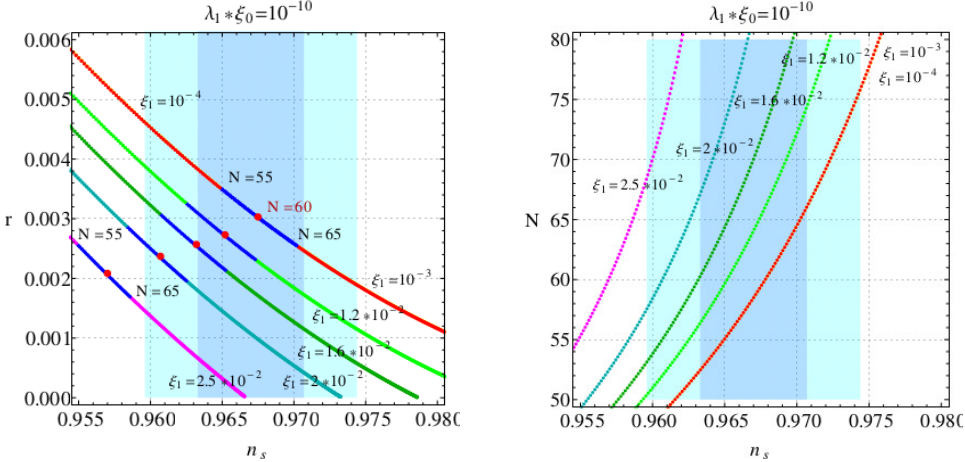
Figure 1 . The potential V ( (cid:27) ) for two (cid:12)xed values of (cid:21) 1 (cid:24) 0 and with di(cid:11)erent (cid:24) 1 . The (cid:13)at region is wide for a large range of (cid:27) , with the width controlled by (cid:13) (cid:24) 1 = We have V=V min / (cid:24) 2 = ( (cid:21) 1 (cid:24) 0 ). 1